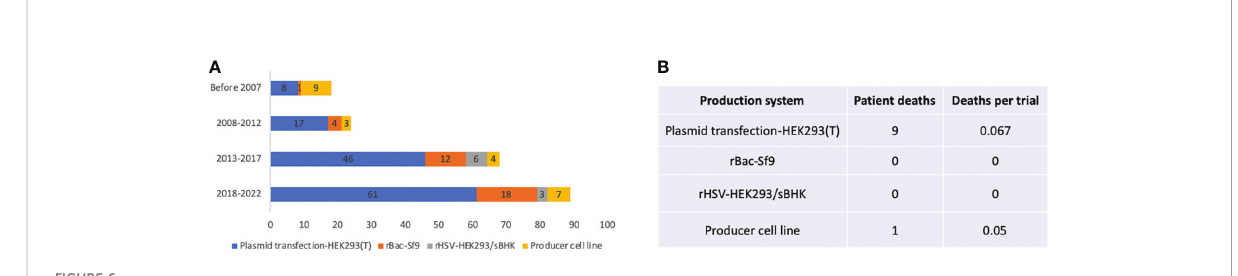
FIGURE 6 Manufacturing systems of 255 AAV clinical trials. (A) System usage in different time periods. (B) Patient deaths in trials using different manufacturing systems. Trials that did not report manufacturing systems are not included for